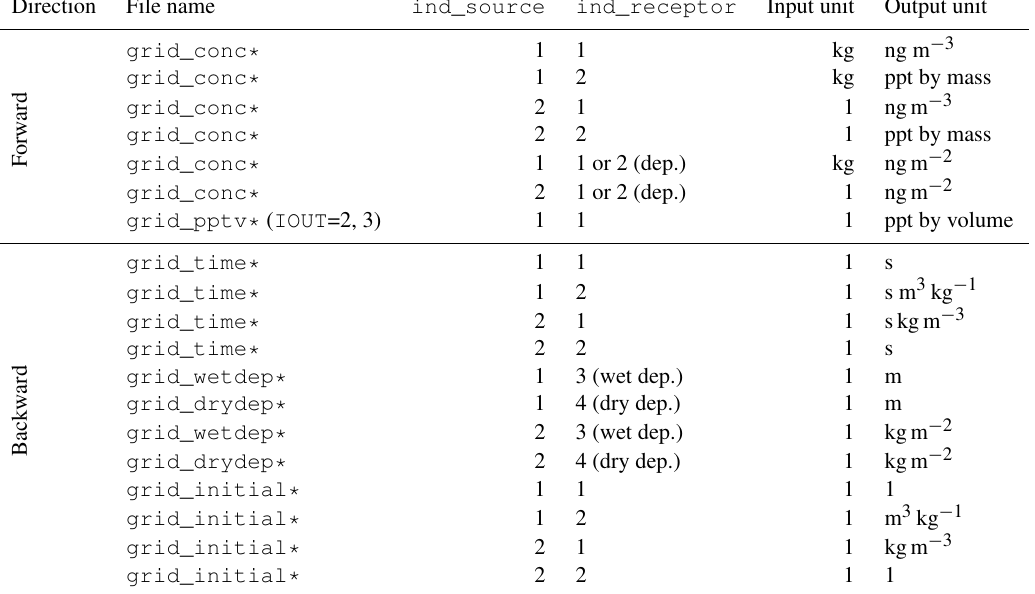
Table 12. Physical units of the input (in file RELEASES ) and output data for forward (files grid_conc_date_nnn ) and backward (files grid_time_date_nnn ) runs for the various settings of the unit switches ind_source and ind_receptor (for both switches, 1 refers to mass units, 2 to mass mixing ratio units). IOUT is 1 (or 9 for NetCDF output) except where indicated; “(dep.)” in lines 5 and 6 of the table refer to the deposition output provided in addition to the atmospheric output in files grid_conc_date_nnn .